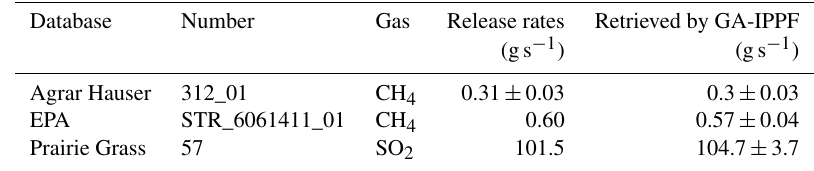
Table 5. Performance of the GA-IPPF model in different control release experiments.